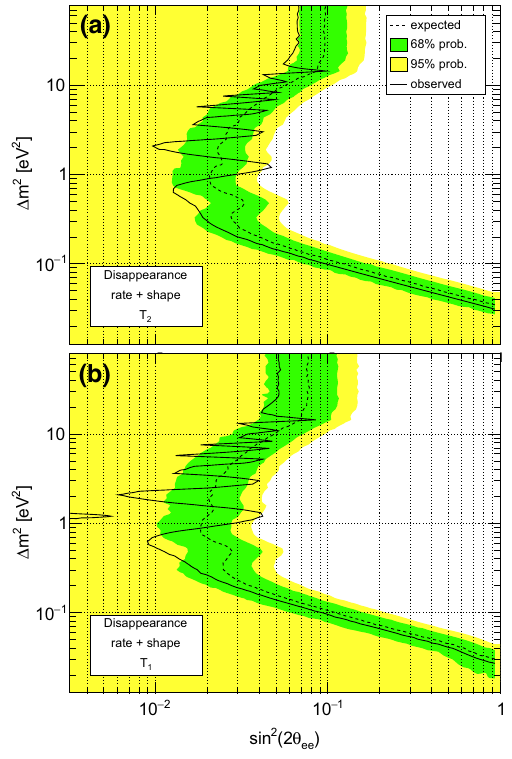
Fig. 3 Confidence regions at 95%-CL for a pseudo-data set generated by the toy disappearance experiment under the no-signal hypothesis. The top plot is obtained using T 2 while the bottom plot using T 1 . The probability distribution of the upper bound of the confidence region expectedunder theno-signal hypothesis isdisplayedthrough itsmedian value (i.e. the exclusion sensitivity) and the 68% and 95% central